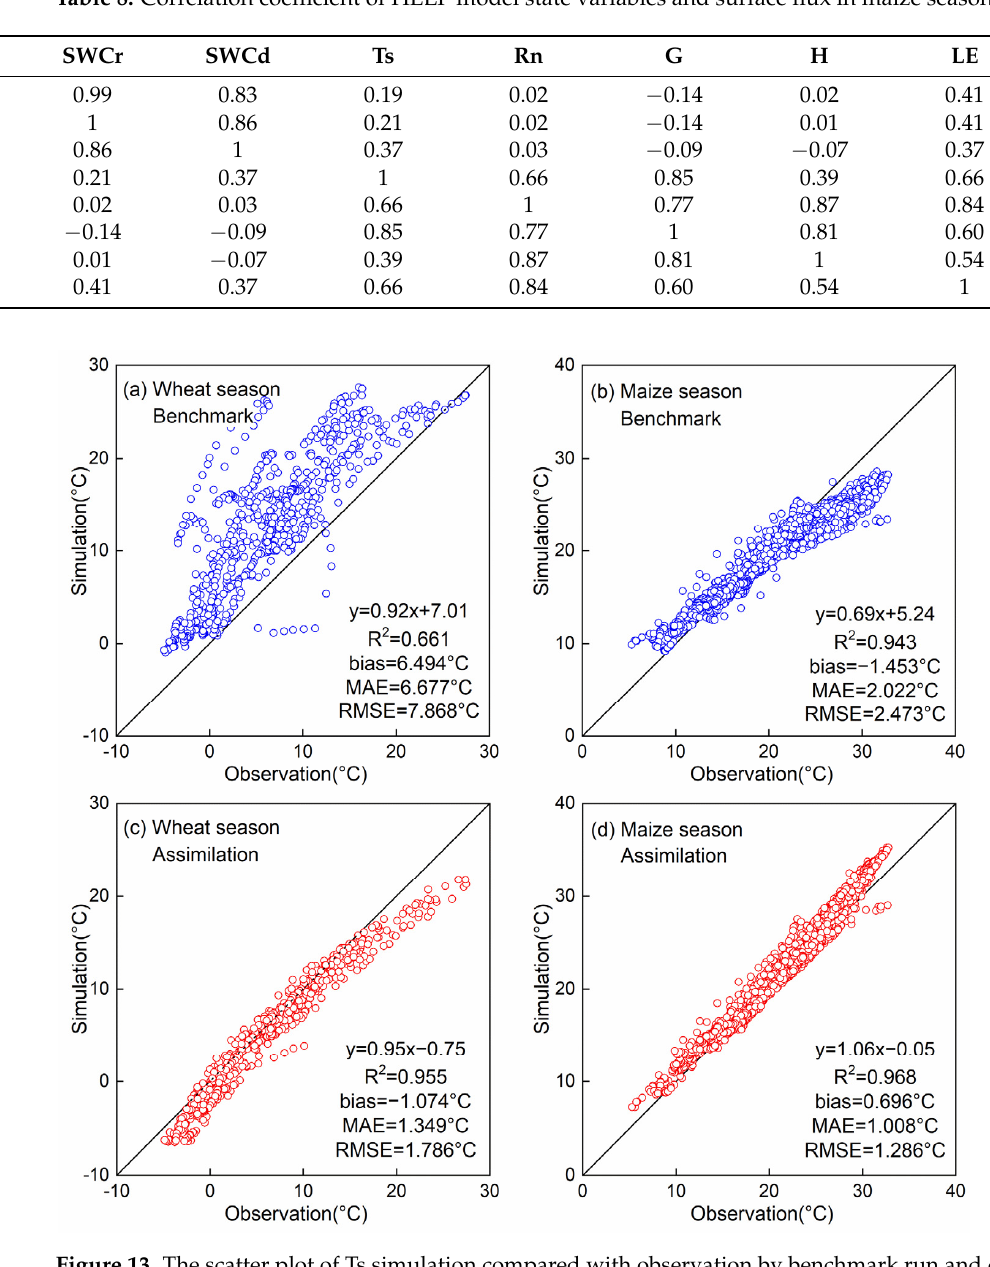
Table 8. Correlation coefficient of HELP model state variables and surface flux in maize season.